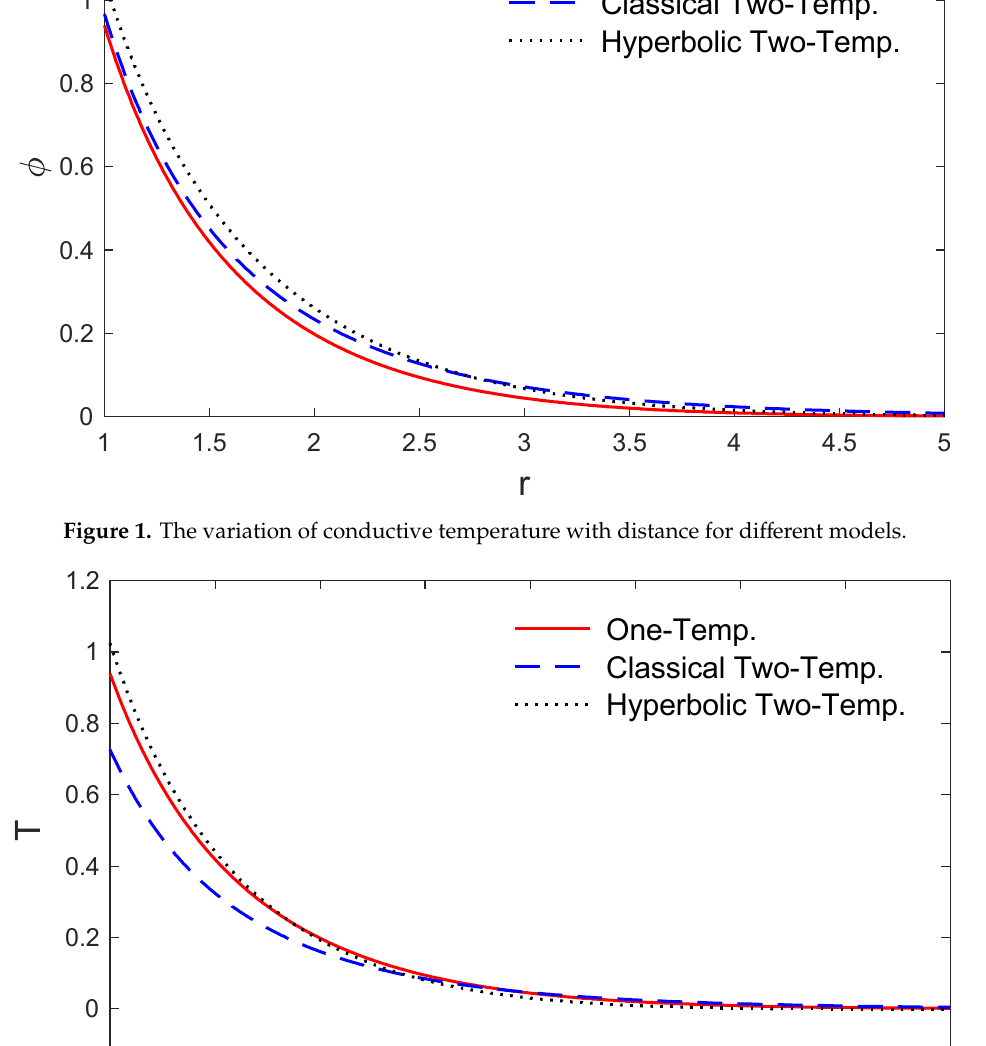
Figure 3. The variation of carrier density with distance for different models.